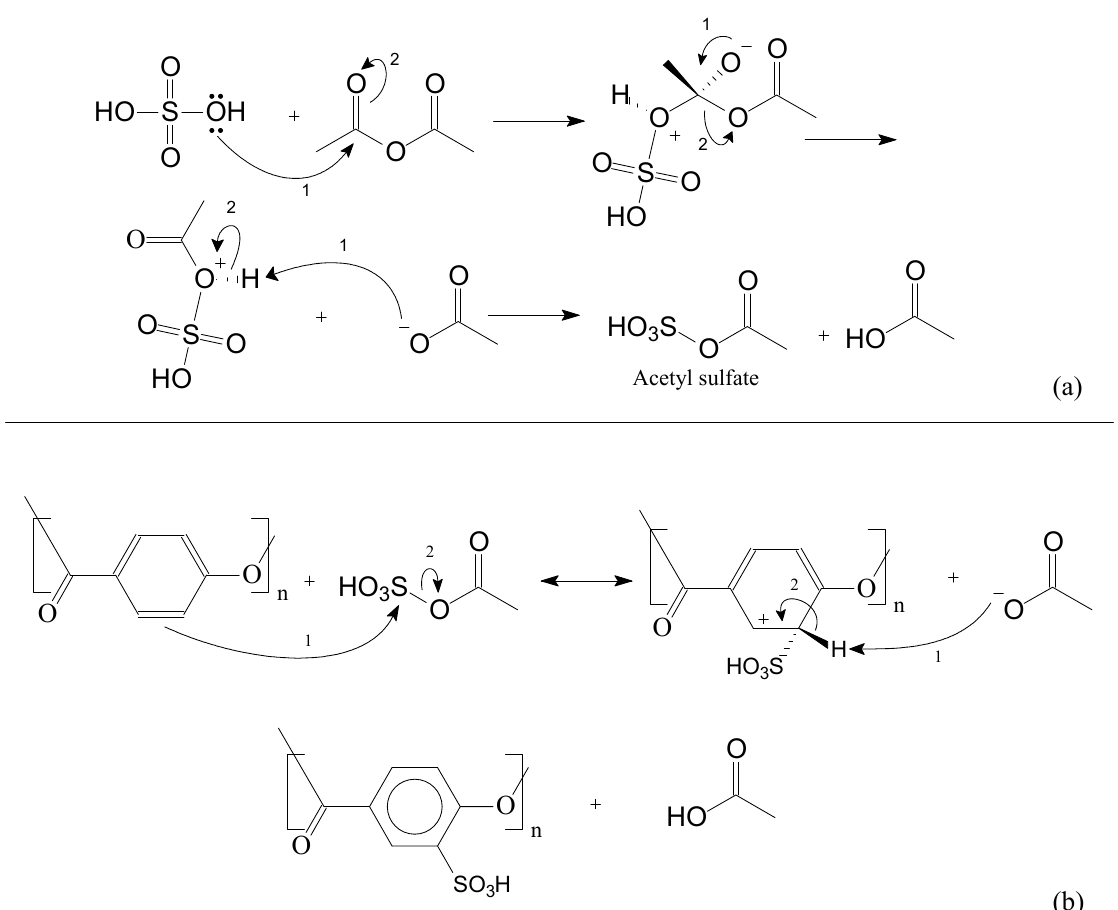
Figure 10. Sulfonation reaction. In ( a ): the acetyl sulfate mechanism and in ( b ) the aromatic electro- philic substitution mechanism.